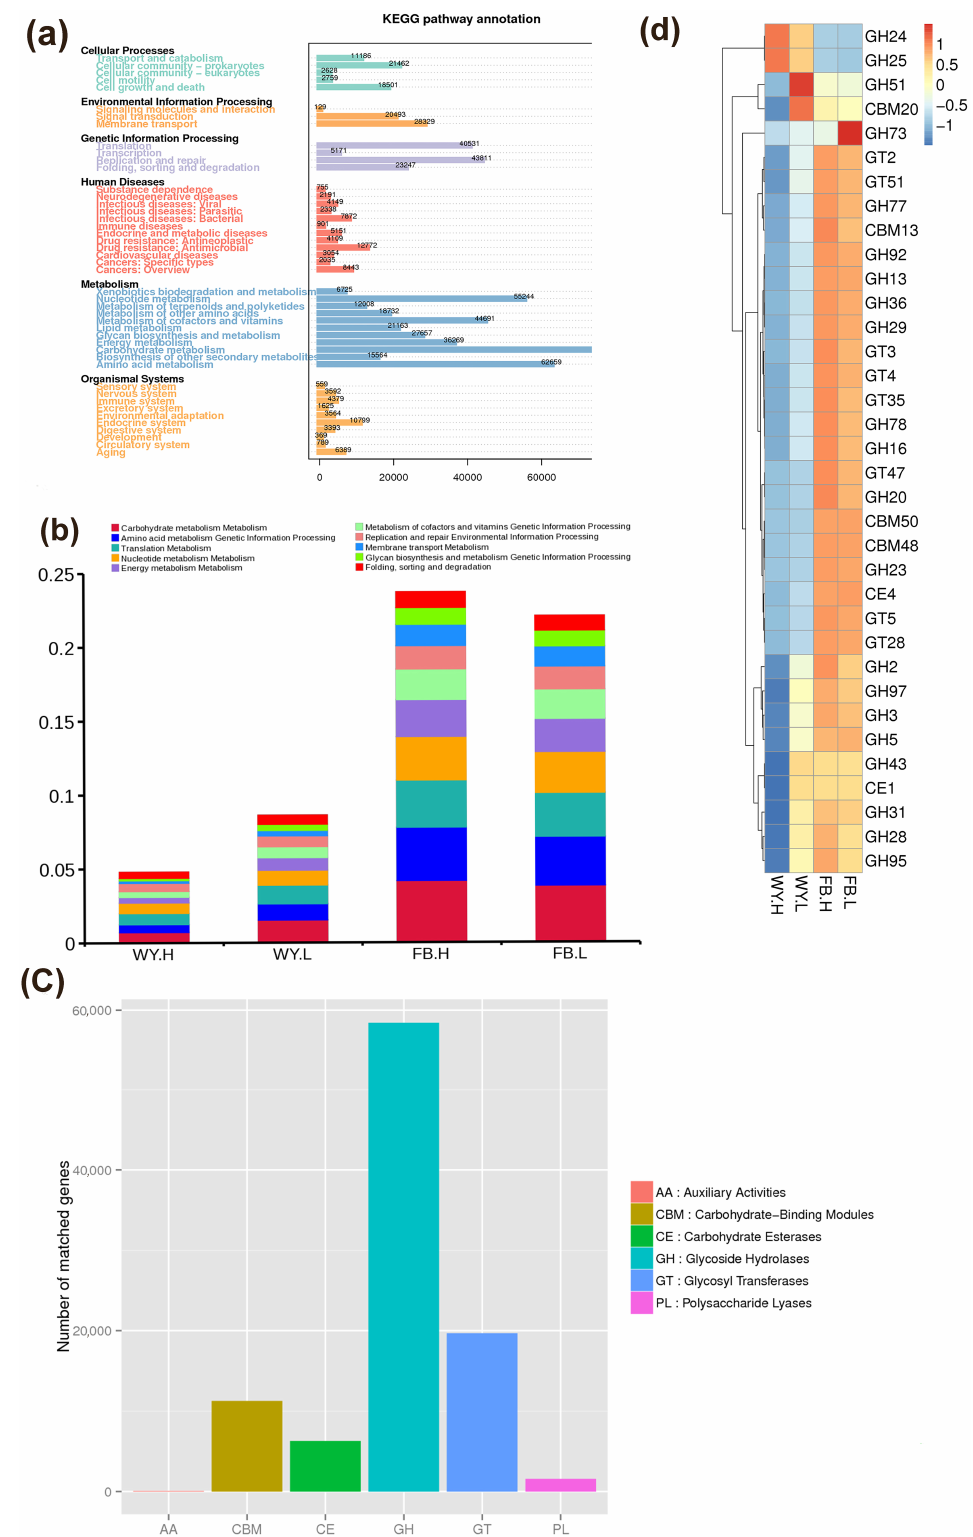
Figure 2. Relative abundance of microbial functions in beef cattle with different RFIs. ( a ) Statistical chart of the number of KEGG annotated genes; ( b ) The relative abundance of top ten KEGG pathways in each group; ( c ) The abundance of six types of CAZy in each group; ( d ) Heatmap of relative abundance of CAZy family clusters in each